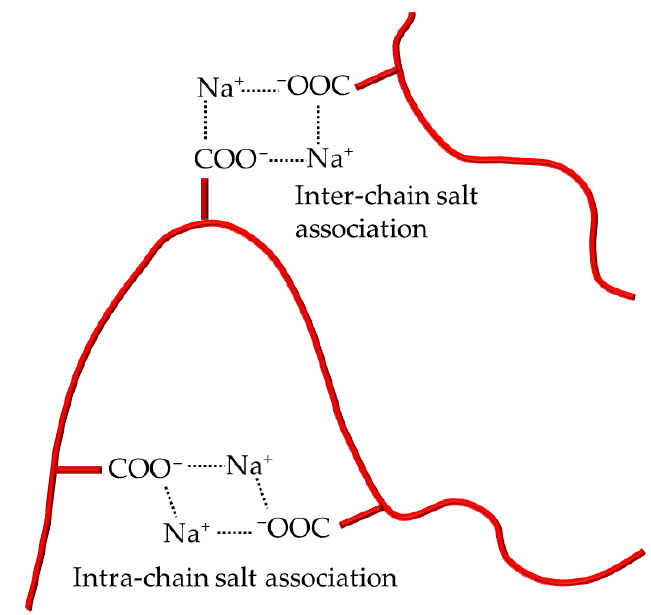
Figure 2. Inter- and intra-chain salt associations in polymer.